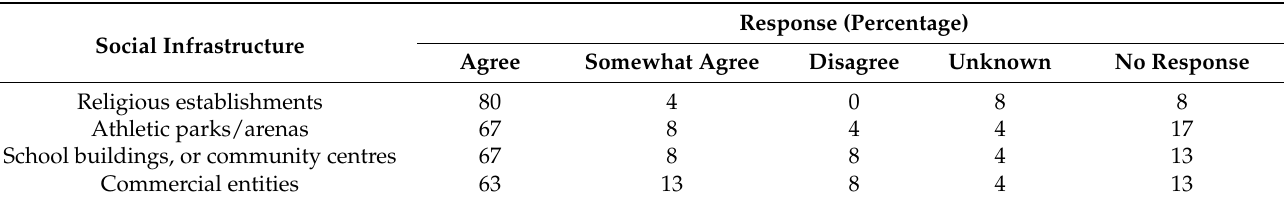
Table 4. Response summary about the placing of the social